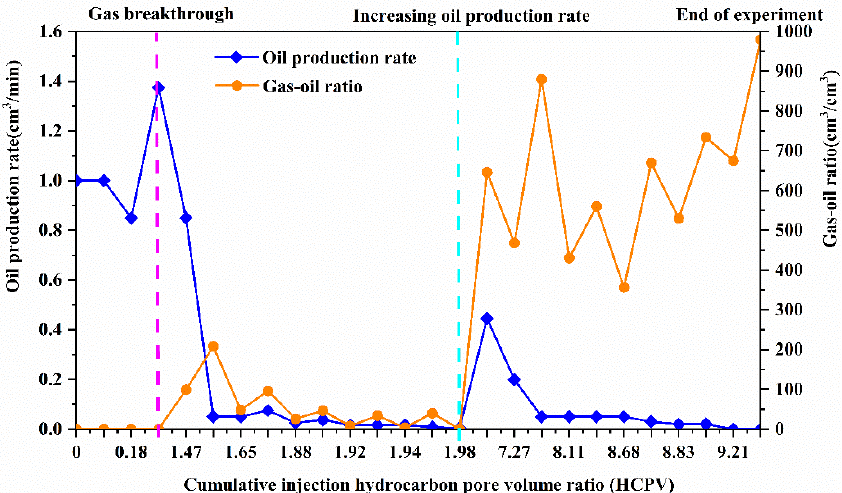
Figure 13. Relationship between cumulative injection hydrocarbon pore volume ratio (HCPV), gas-oil ratio, and oil production rate.